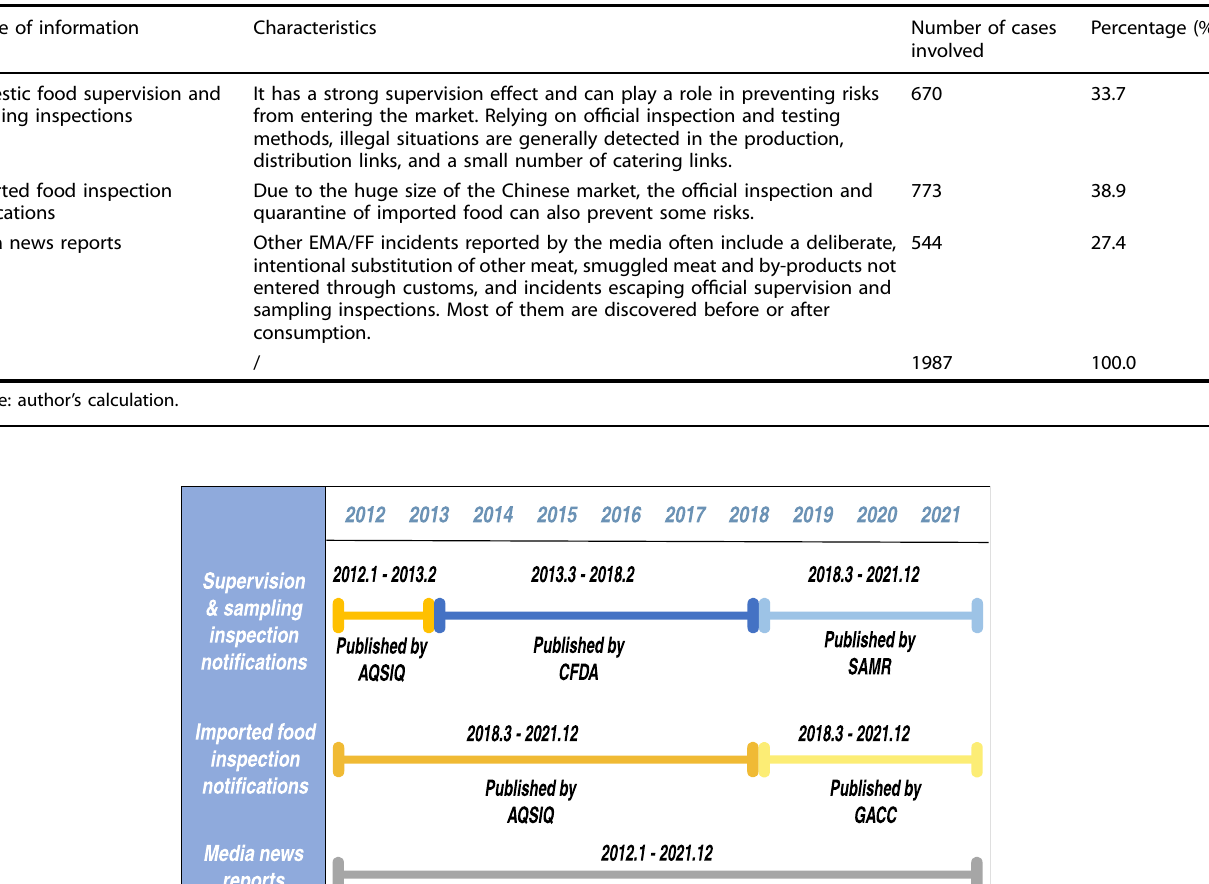
Table 8. Sources and characteristics of statistical data.